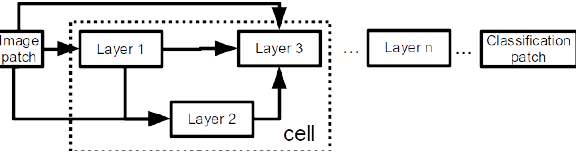
Figure 2. A general illustration of a CNN represented as an acyclic graph.